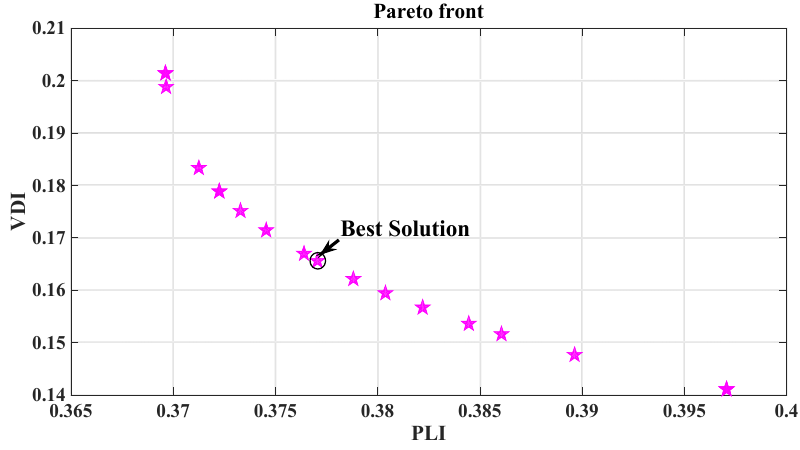
Figure 3. Pareto front for the placement of single DG.